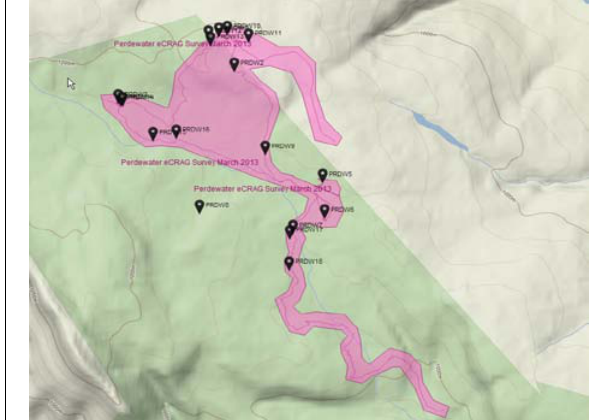
Figure 5. Map of sites (archival and recently surveyed) overlaid with the area surveyed.